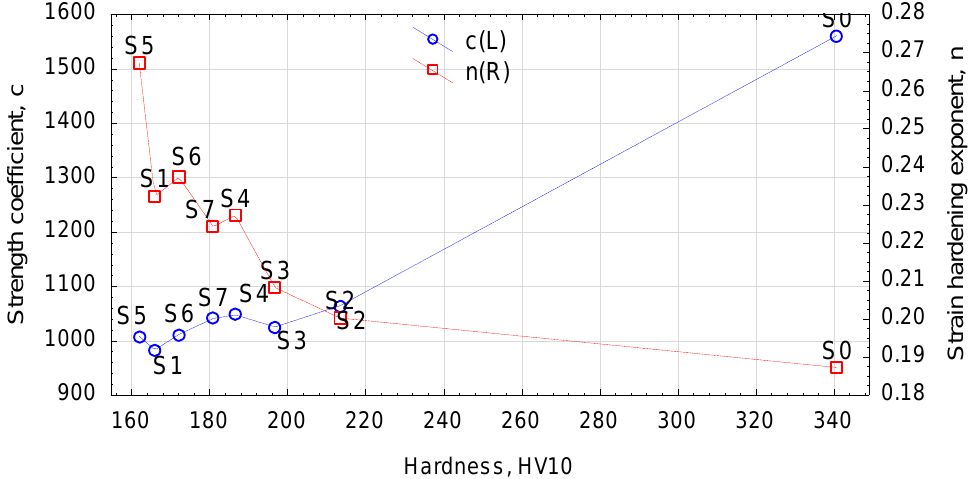
Figure 11. E ff ect of hardness on strain-hardening coe ffi cients. Figure 11. Effect of hardness on strain-hardening coefficients.